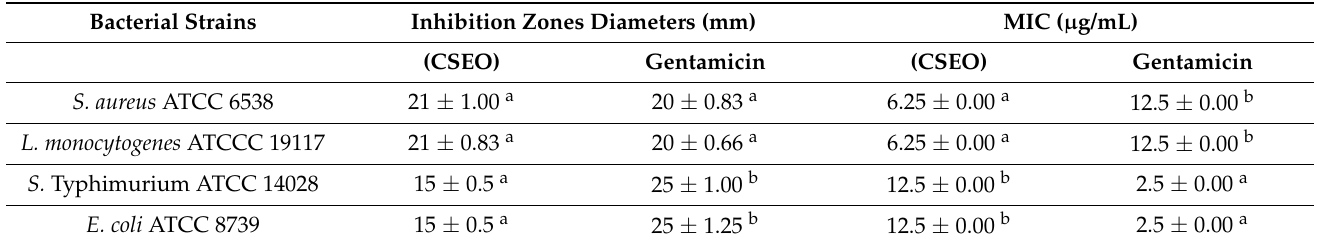
Table 2. Antibacterial activity of (CSEO); zones of growth inhibition expressed in (mm) and minimum inhibitory concentrations (MICs) expressed in ( µ g/mL) of the (CSEO) and the standard antibiotic gentamicin. All tests were performed in triplicate; values with a different letter (a,b) within a row for each antibacterial test are significantly different ( p <